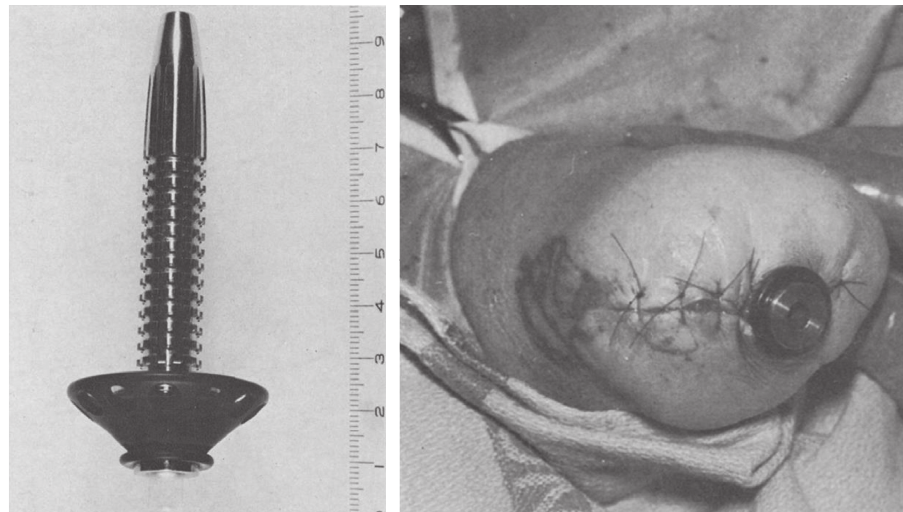
Figure 9: Transcutaneous skeletally linked prosthesis implant. A stainless steel implant was cemented into transhumeral amputees in the 1970s (adapted with permission from Mooney, V., Schwartz, S.A., Roth, A. M. et al. Ann Biomed Eng (1977) 5: 34. A sustained effort at limb